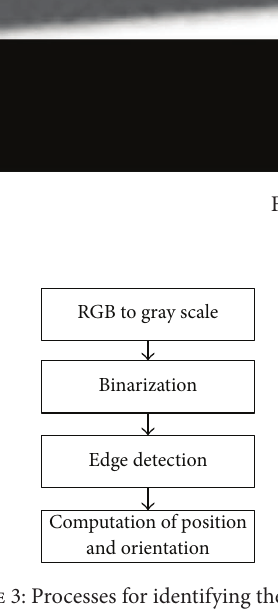
6 degrees of freedom of the markers, with the position in centimeters and angles in degrees. In Figure 6 presents the display panel of the interface. The red line in the image of the right indicates the